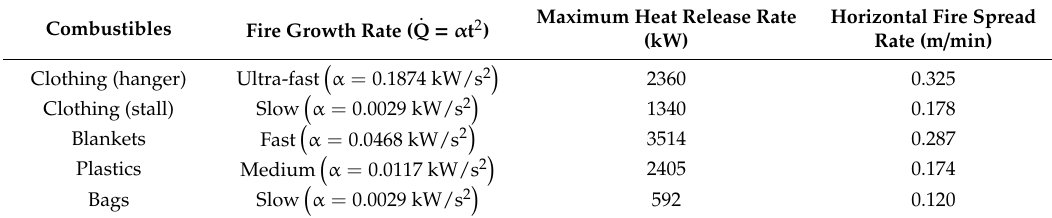
Table 2. Summary of experimental results for the major combustibles in traditional markets.